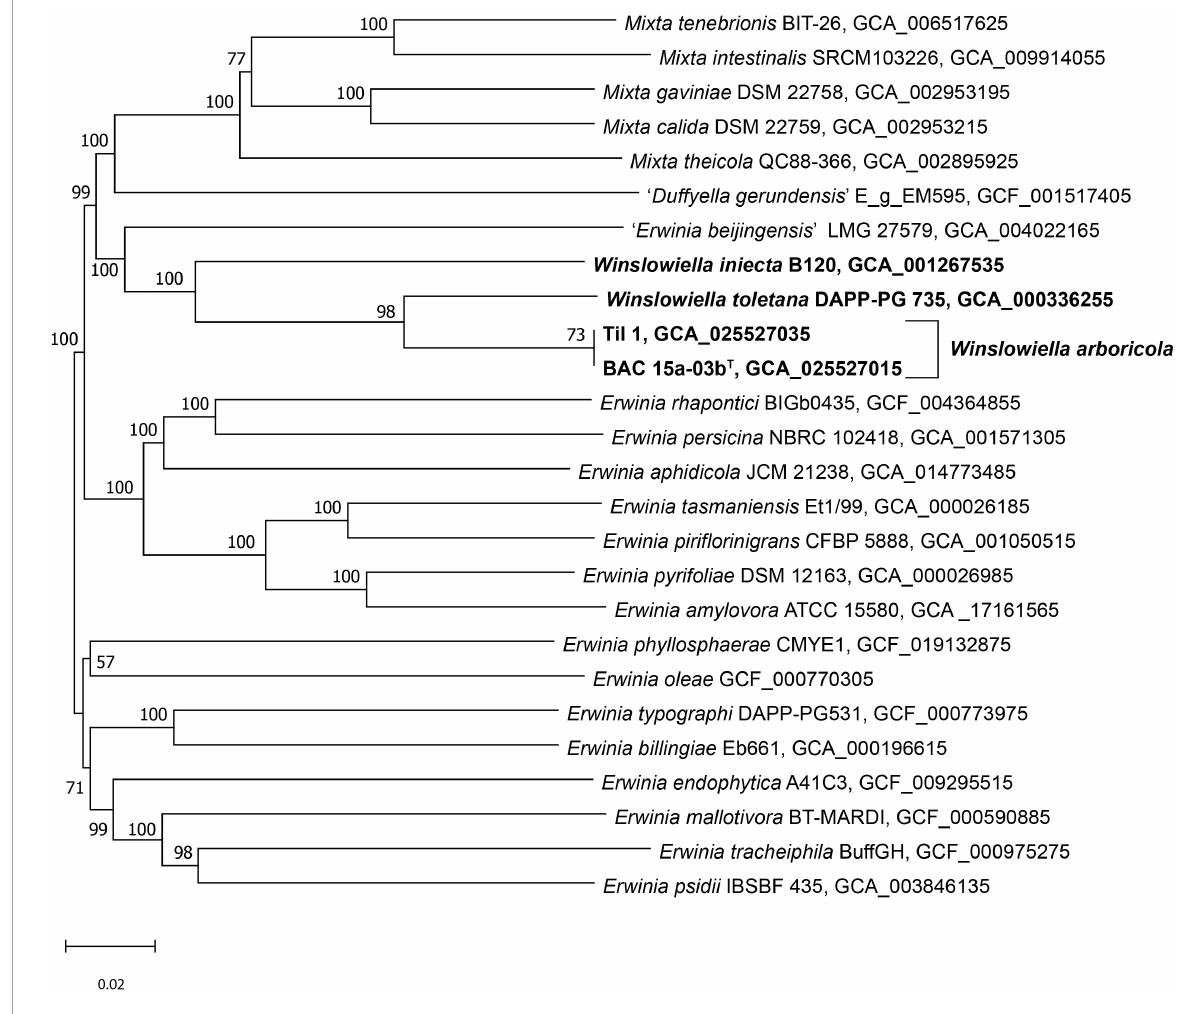
FIGURE2 Phylogenomic tree of Winslowiella gen. nov., Winslowiella arboricola sp. nov., and phylogenetic relatives. GBDP pseudo-bootstrap support values > 60% shown at the nodes (from 100 replicates), with an average branch support of 85.4%. The branch lengths are scaled in terms of GBDP distance formula d 5 and the tree is rooted at the midpoint. T , type